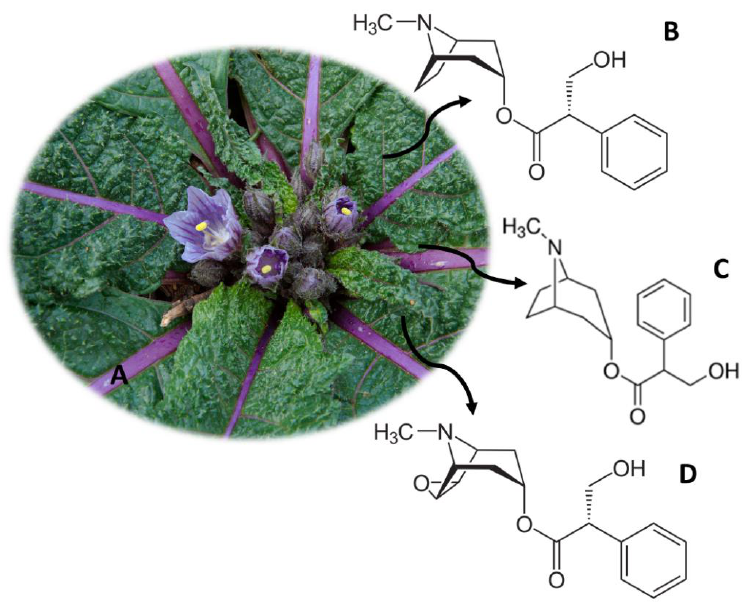
Figure 6. M. officinarum ( A ) and the main compounds hyoscyamine ( B ), atropine ( C ) and scopolamine ( D ).